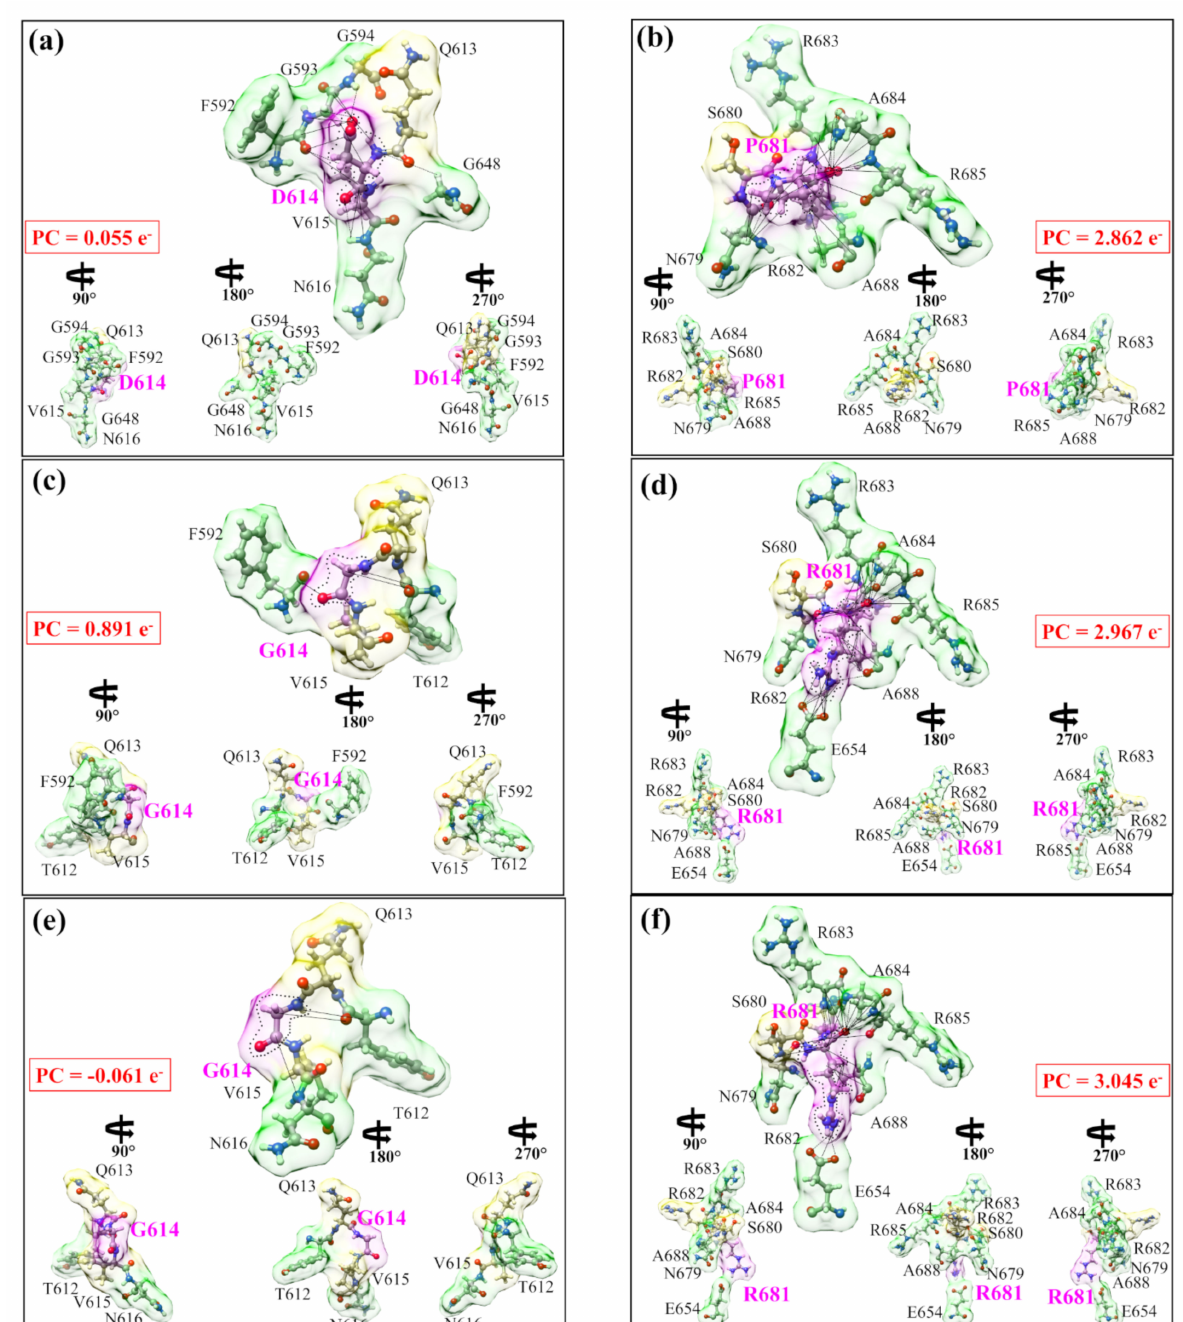
Figure 4. Details of the actual distribution of the three cases of interactions in the AABP calculation: ( a , b ) for the WT, ( c , d ) for the single mutation, and ( e , f ) for the double mutation. The left panel in each case is centered on 614th site and the right panel is centered on 681st site, and are both colored pink. The NN AAs are colored light yellow, and the NL AAs are colored light green. All the AAs involved in the interaction are marked. The lines show the NL bonded pairs. For each case, we show the NN AAs and the NL AAs that contribute to the AABP values. It also shows drastic difference between the mutation D614G and P681R in the shape, size, and orientation, and the total number of AAs involved in each case. The PCs for each groups of AAs in the AABP calculation are listed in the red box, showing large difference both in the sign and the